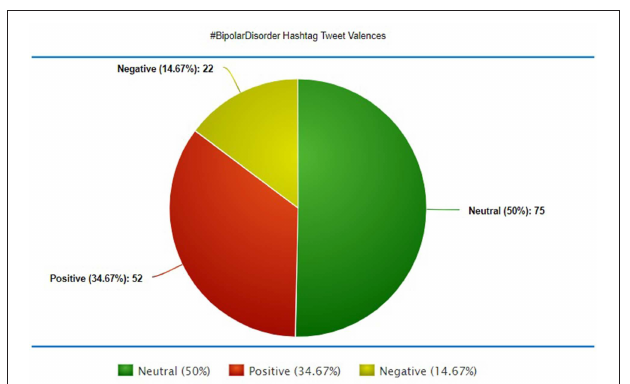
FIGURE 4 | Valences of Tweets in #BipolarDisorder